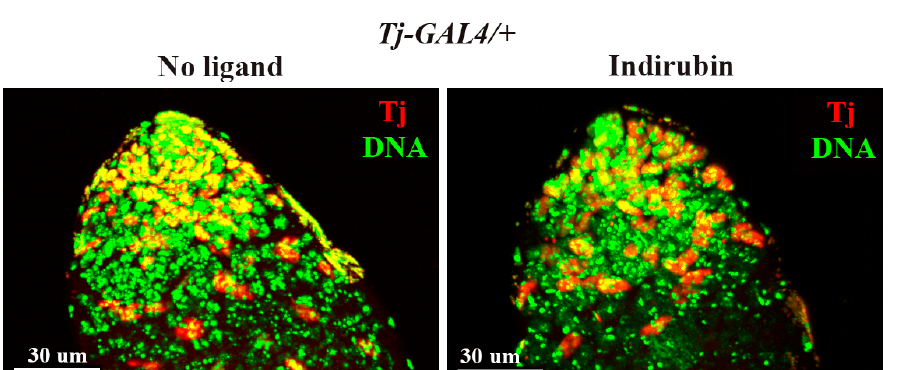
Figure A1. Merged confocal immunofluorescence images of apical tips of testis stained with SytoxGreen to highlight DNA (green) and anti-Tj to visualize Tj-positive cells (red). Testes are from Tj-Gal4/+ males: (left) raised on standard medium; (right) fed for 3 days with indirubin. A number of Tj-positive cells in testis of flies developed on standard medium or fed with xenobiotic was the same (100.1 ± 5.2; n = 22 and 104.8 ± 7.7; n = 19 correspondently). Scale bars, 30 µm.